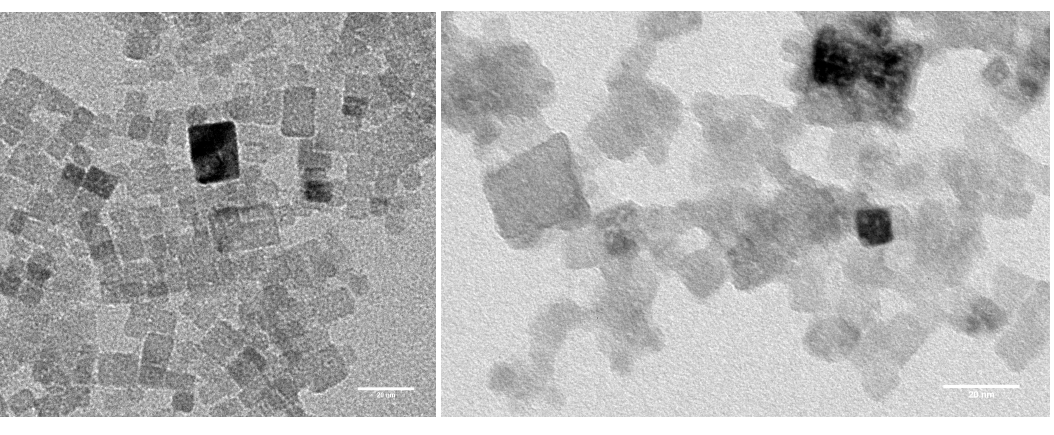
Figure 6. TEM images of CaF 2 ( left ) and SrF 2 ( right )